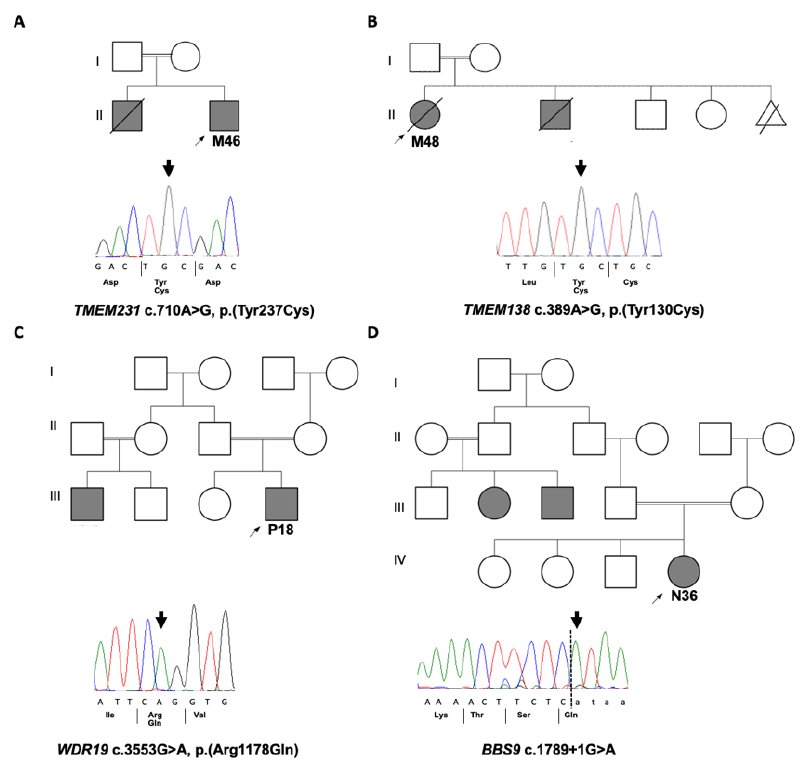
Figure 1. Family structures and Sanger sequencing in solved renal ciliopathy cases. Pedigrees of solved families with Sanger sequecing chromatograms confirming the disease causative variants that were identified by WES in four families. A . M46 with homozygous missense variant in TMEM231 . B . M48 with homozygous missense variant in TMEM138 . C . P18 with homozygous missense variant in WDR19 D . N36 with homozygous splice site variant in BBS9